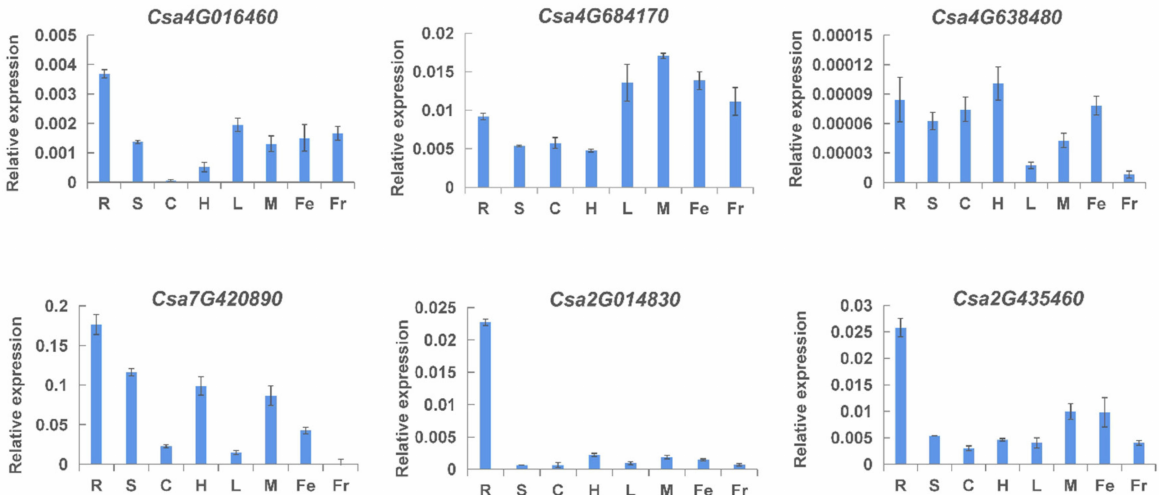
Figure 7. Tissue-specific expression analysis of the CNL genes in cucumber plants by qRT-PCR. R: root; S: stem; C: cotyledon; H: hypocotyl; L: leaf; M: male flower; Fe: female flower; and Fr: fruit. The vertical axis is relative to the expression level and x -axis represents different tissues. Values are mean ± SE (n =